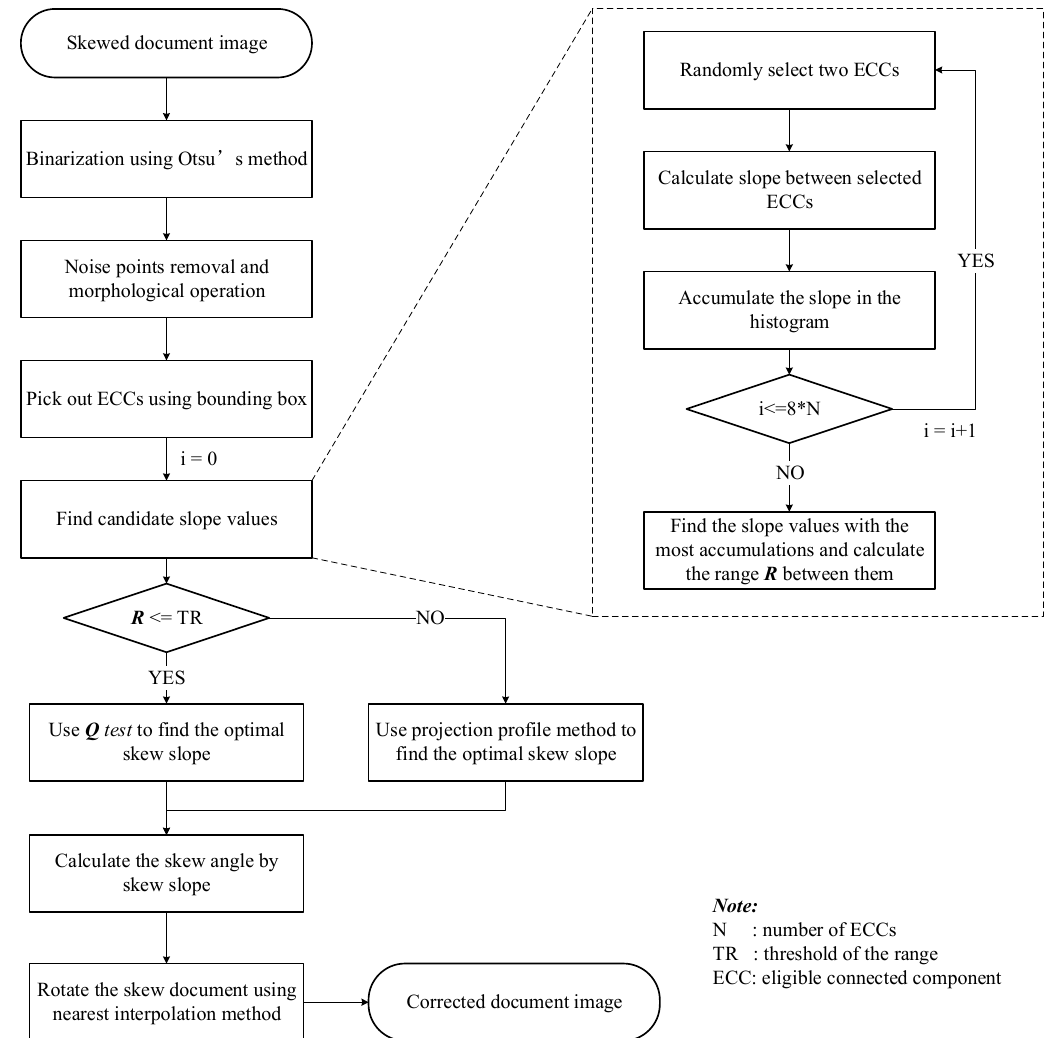
Figure 1. Flowchart of proposed method. ECC: eligible connected components.